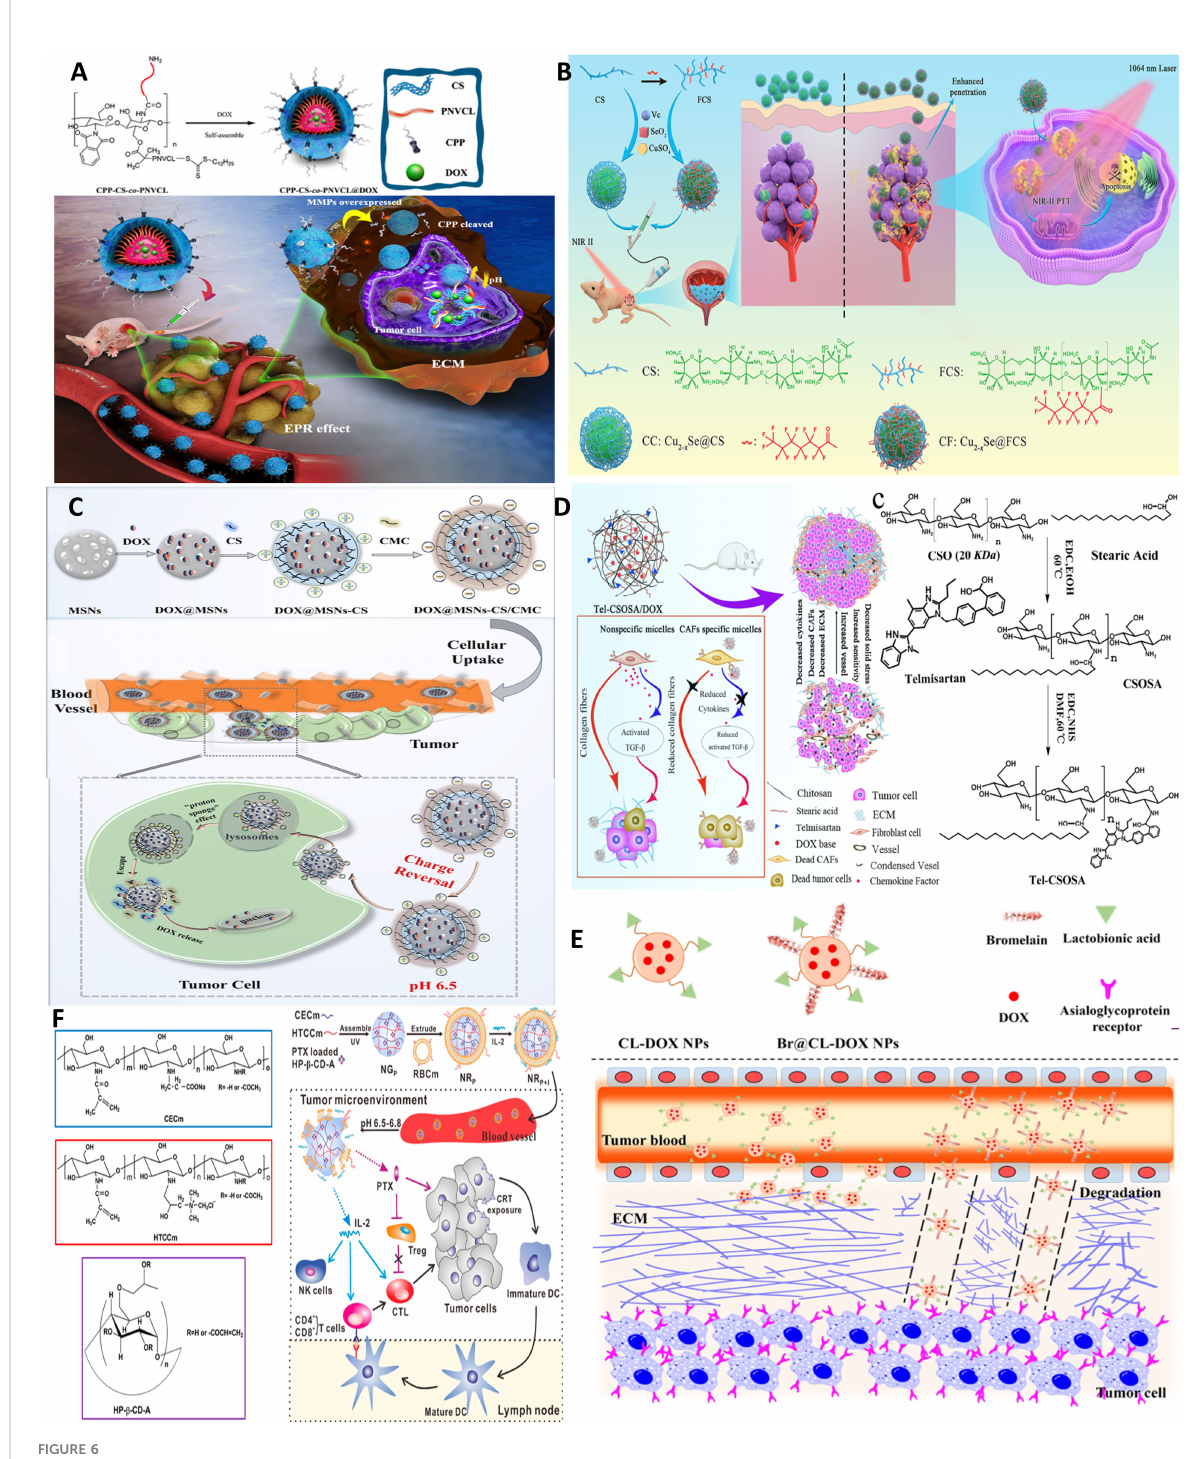
FIGURE 6 Chitosan NPs affords crossing stroma and biological membranes. (A) EPR and CPP-mediated active targeting. Reprinted from (15) under Creative Commons Attribution License 4.0, Copyright (2019) Springer Nature. (B) FC affords superior mucoadhesion potential to cross epithelial barriers of bladder cancer. Reprinted with permission from (80), Copyright (2021) Wiley ‐ VCH GmbH. (C) Multi-stage acting CS NPs. Reprinted with permission from (81), Copyright (2019) American Chemical Society. (D) Stroma cell depletion afforded by chitosan-modi fi ed CAF inhibitor. Reprinted with permission from (74), Copyright (2018) Elsevier. (E) Chitosan nanosweeper for ECM drilling. Reprinted with permission from (82), Copyright (2018) Elsevier. (F) Chitosan-clocked NPs with RBC membrane as Trojan system. Reprinted from (83), Copyright (2017) American Chemical